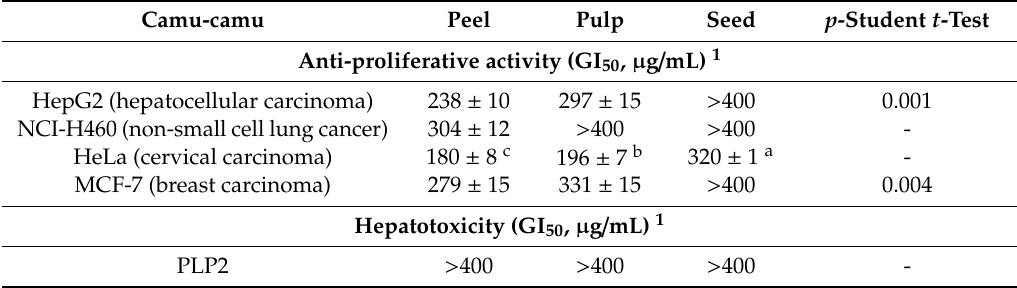
Table 3. Anti-proliferative and hepatotoxic potentials of the distinct camu-camu ethanolic extracts (peel, pulp, and